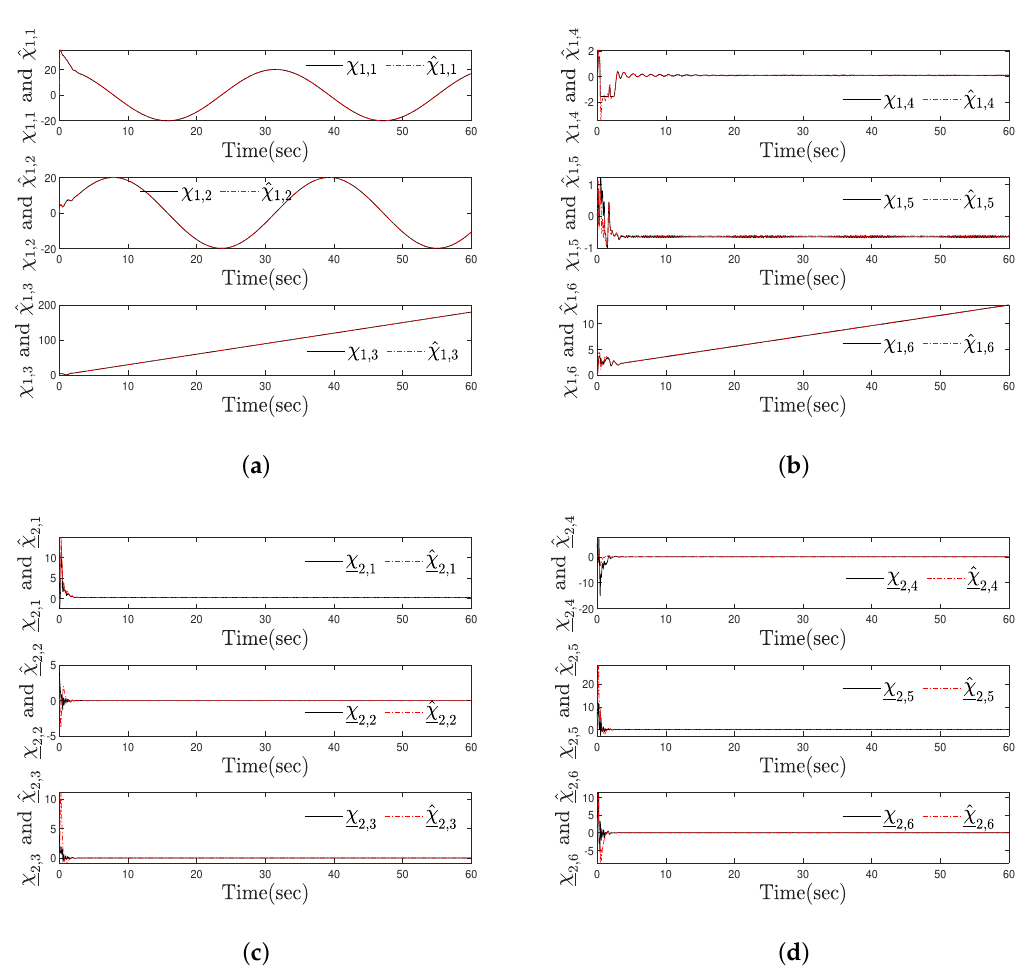
Figure 10. State estimation results of the proposed approach for Scenario 2 ( a ) χ 1,1 , ˆ χ 1,1 , χ 1,2 , ˆ χ 1,2 , χ 1,3 and ˆ χ 1,3 ( b ) χ 1,4 , ˆ χ 1,4 , χ 1,5 , ˆ χ 1,5 , χ 1,6 and ˆ χ 1,6 ( c ) χ 2,1 , ˆ χ 2,1 , χ 2,2 , ˆ χ 2,2 , χ 2,3 and ˆ χ 2,3 ( d ) χ 2,4 , ˆ χ 2,4 , χ 2,5 , ˆ χ 2,5 , χ 2,6 and ˆ χ 2,6 .